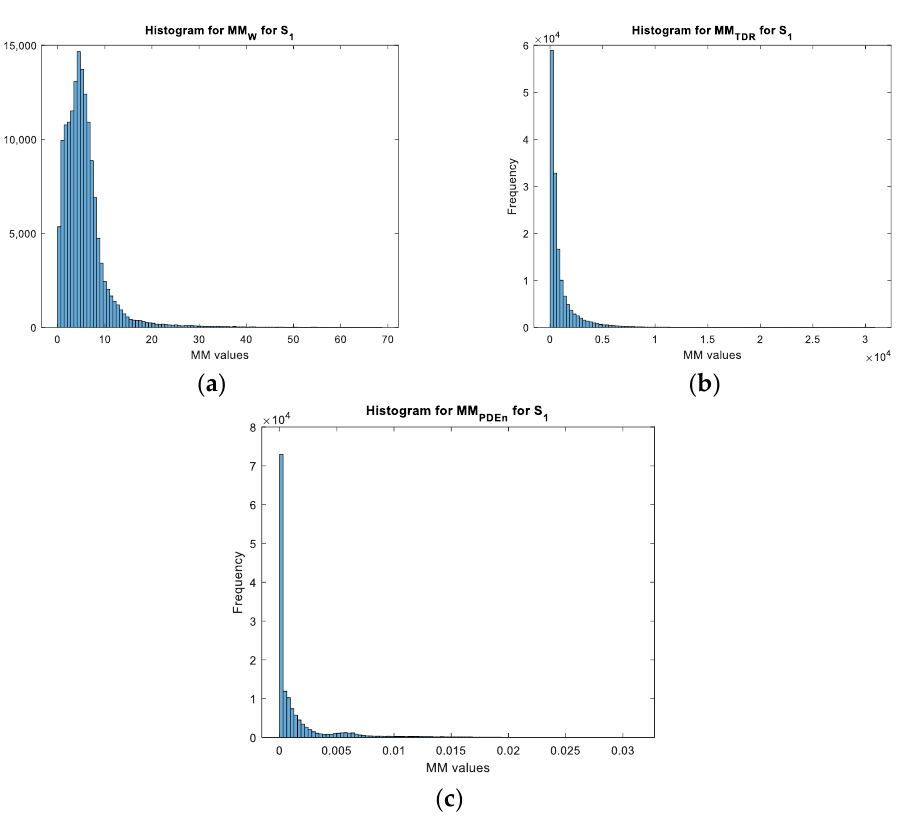
Figure 11. The histogram for the movement maps from S1 for the LSS UAV target: ( a ) The wavelet transform approach; ( b ) the TDR approach; and ( c ) the PDEn approach.